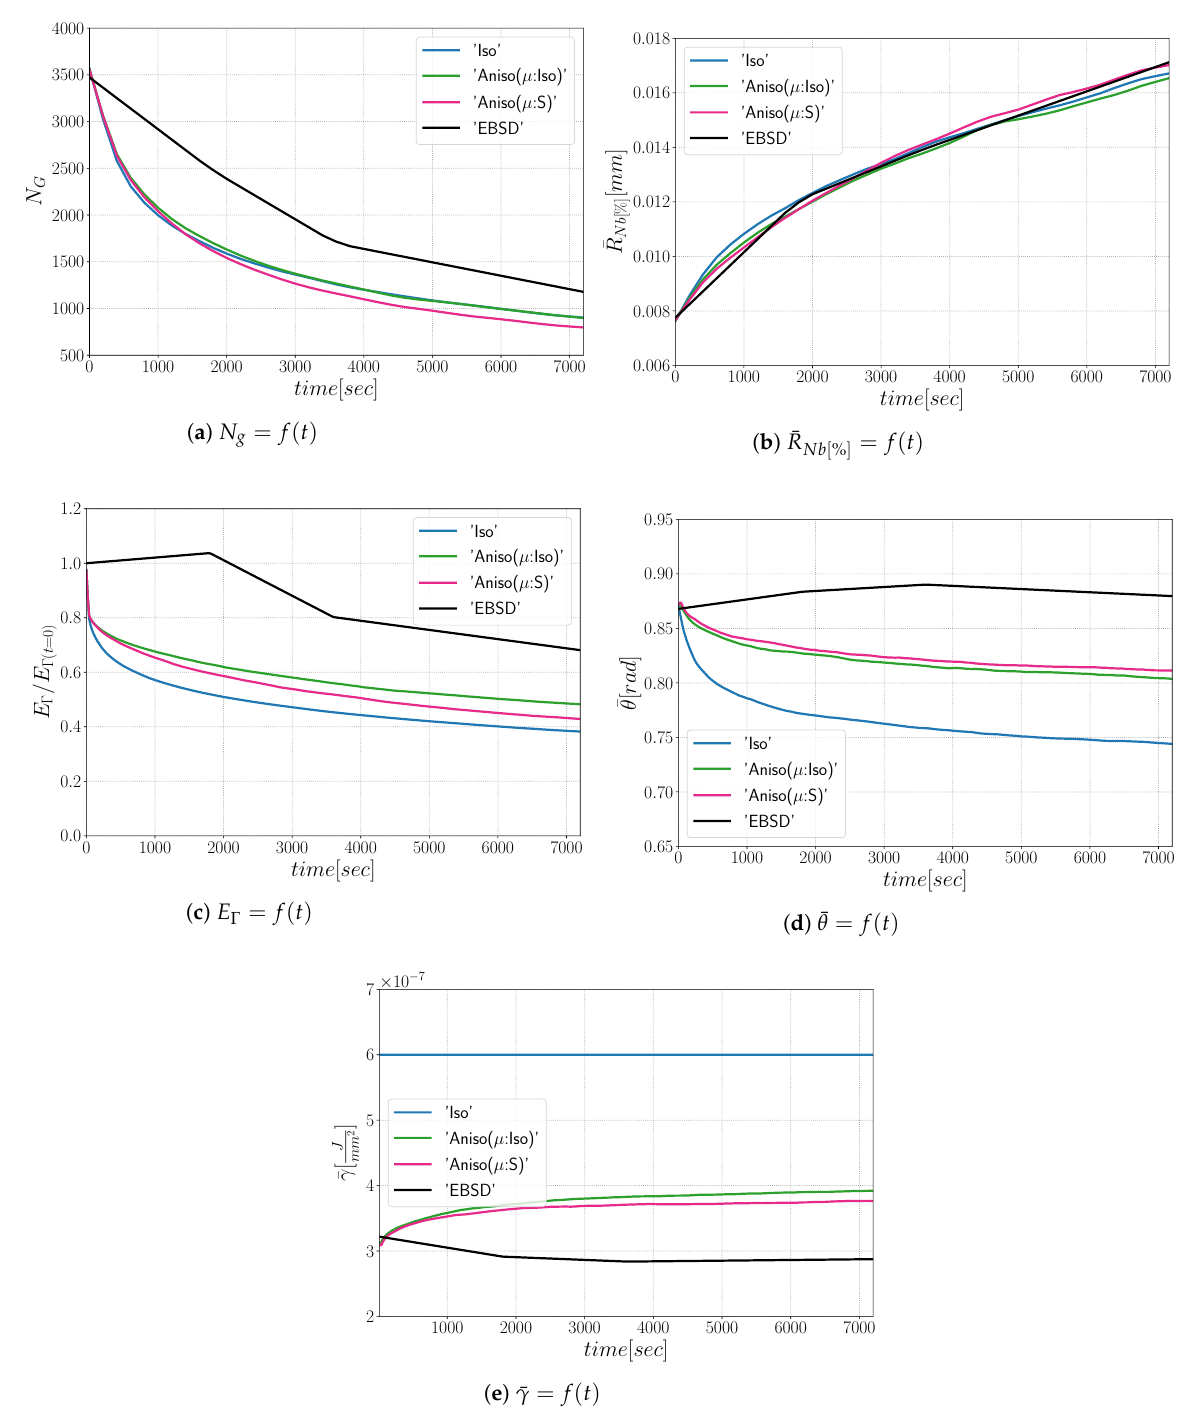
Figure 21. Mean values time evolution for the isotropic (Iso) formulation, anisotropic formulations with isotropic GB mobility (Aniso( µ :Iso)) and heterogeneous GB mobility (Aniso( µ :S)), and the experimental data (EBSD). Numerical results obtained from the initial microstructure shown in Figure